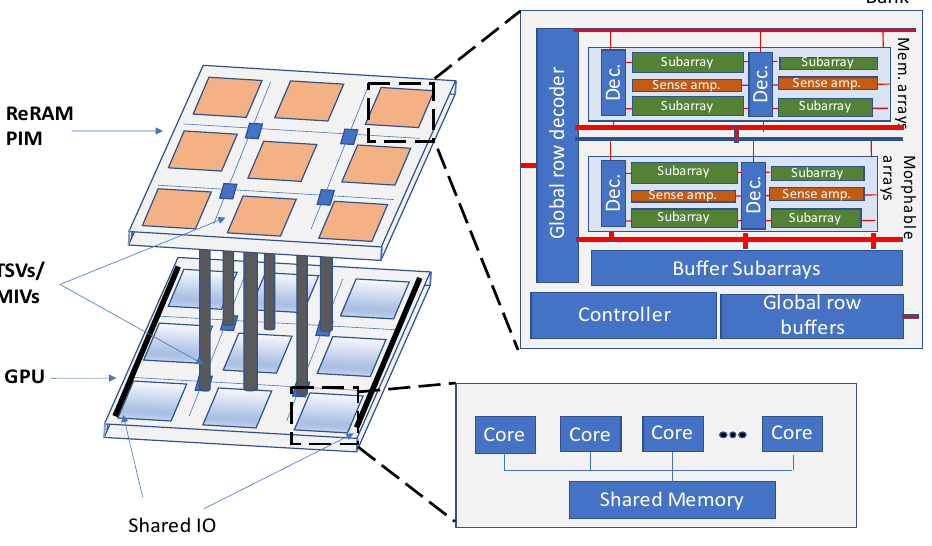
Figure 25. An overview of the 3D-ReG architecture [27].